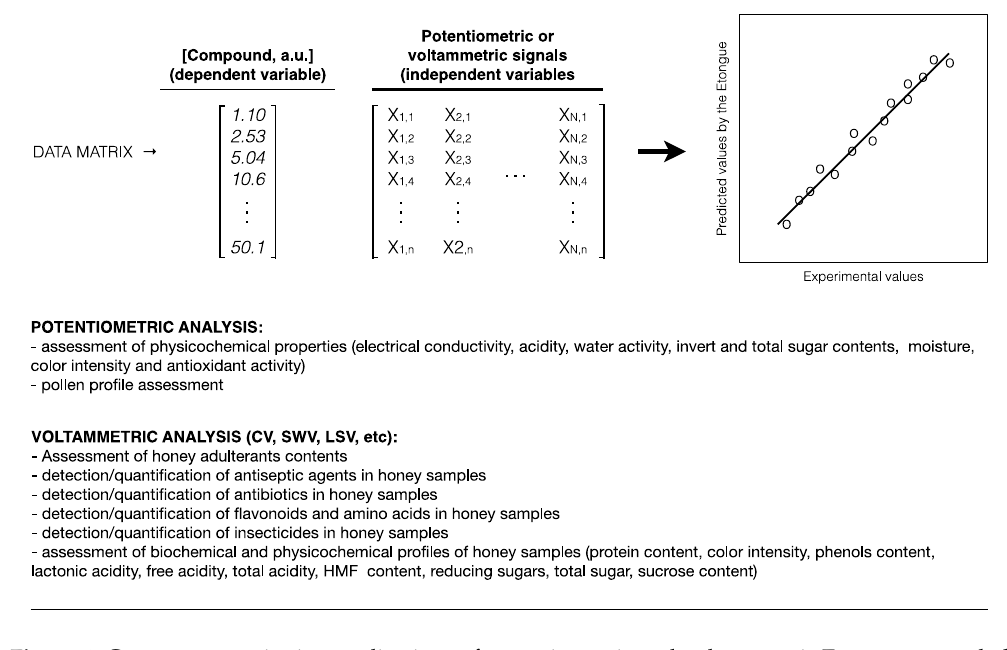
Figure 4. Common quantitative applications of potentiometric and voltammetric E-tongues coupled with chemometric tools for honey analysis, according to the literature survey.